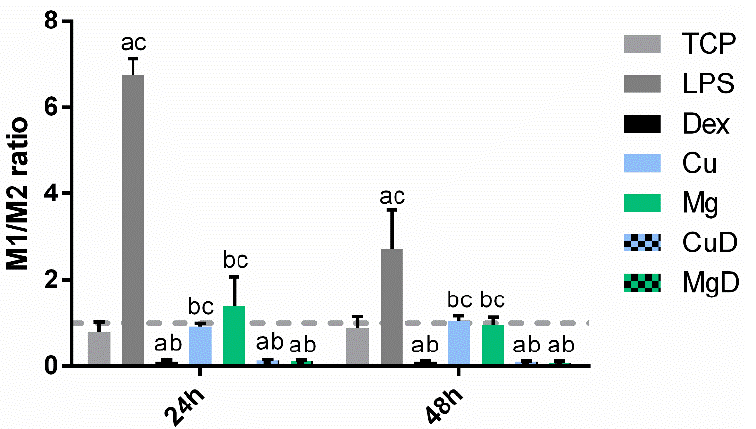
Figure 4. M1/M2 ratio of macrophages stimulated with dex and the combination of dex with Cu 2+ and Mg 2+ . M1/M2 ratio was calculated from the gene expression of CCR7 and CD206 markers. The results of the M1/M2 ratio for each condition were compared to the TCP of each day. Statistically significant differences compared to TCP, LPS and dex were indicated with a, b or c, respectively ( p < 0.05).